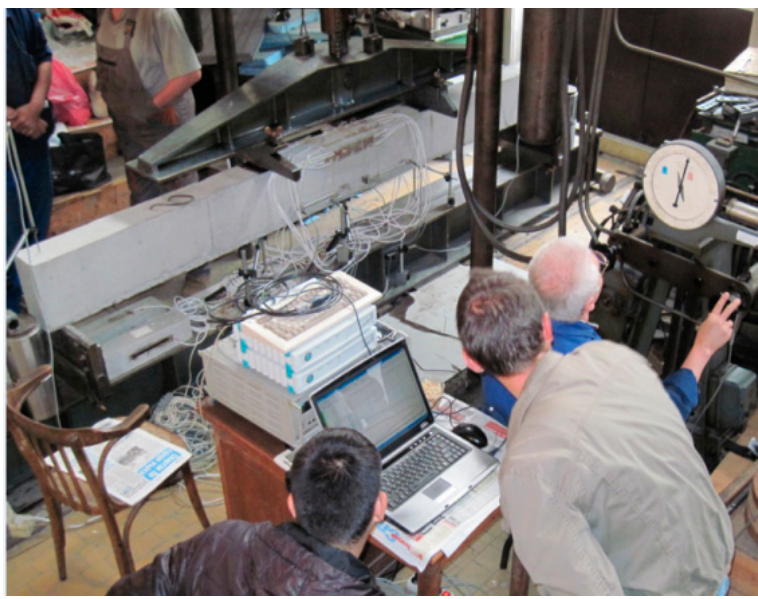
Figure 3. Load of the beams (personal archive).